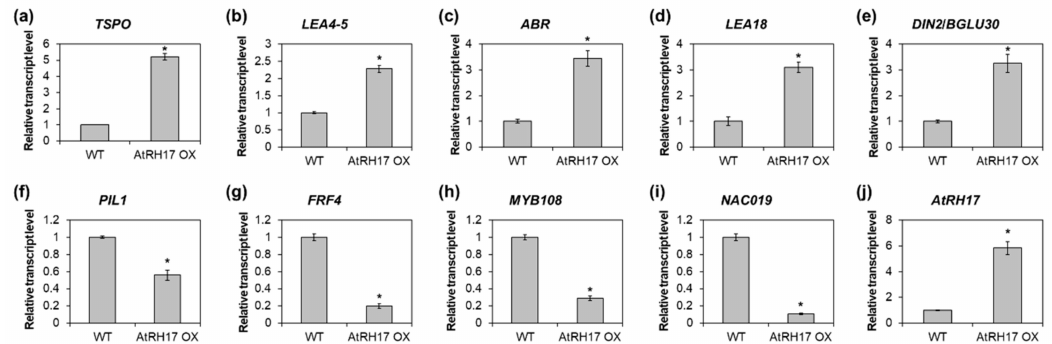
Figure 5. Verification of up- and downregulated genes in AtRH17 OXs. Quantitative RT-PCR analysis of TSPO ( a ), LEA4-5 ( b ), ABR ( c ), LEA18 ( d ), DIN2 / BGLU30 ( e ), PIL1 ( f ), FRF4 ( g ), MYB108 ( h ), NAC019 ( i ), and AtRH17 ( j ) in 10-day-old WT and AtRH17 OX seedlings. GAPc was used as an internal control. Transcript levels in WT were set as 1. Three independent reactions were performed for each technical replicate. Two technical replicates were performed for each biological replicate. At least two biological replicates showed similar results, with one shown here. Error bars represent standard deviation ( n = 6 reactions) and * indicates t -test p < 0.05.